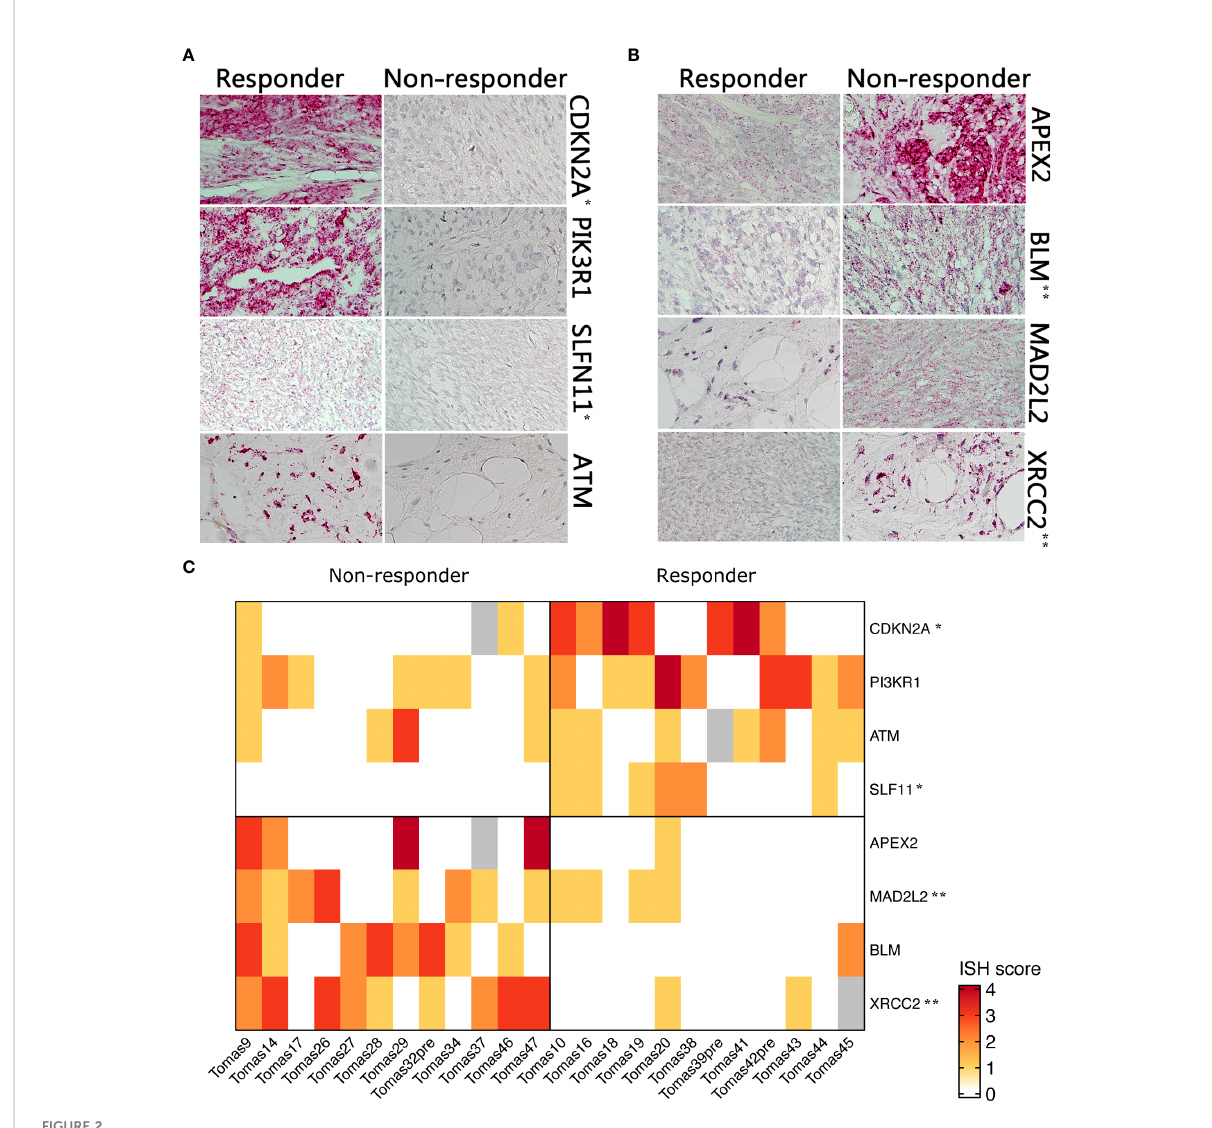
FIGURE 2 RNA ISH of selected genes in responder vs. non-responder patients. (A) Higher expressed genes in responder patients (B) higher expressed genes in non-responders (C) . Heatmap showing differential RNA ISH staining between responder and non-responder patients. ISH score was assigned by an expert pathologist on the basis of staining intensity and percentage of positive cells. P-value was calculated by Chi-square test. *p<0.05;